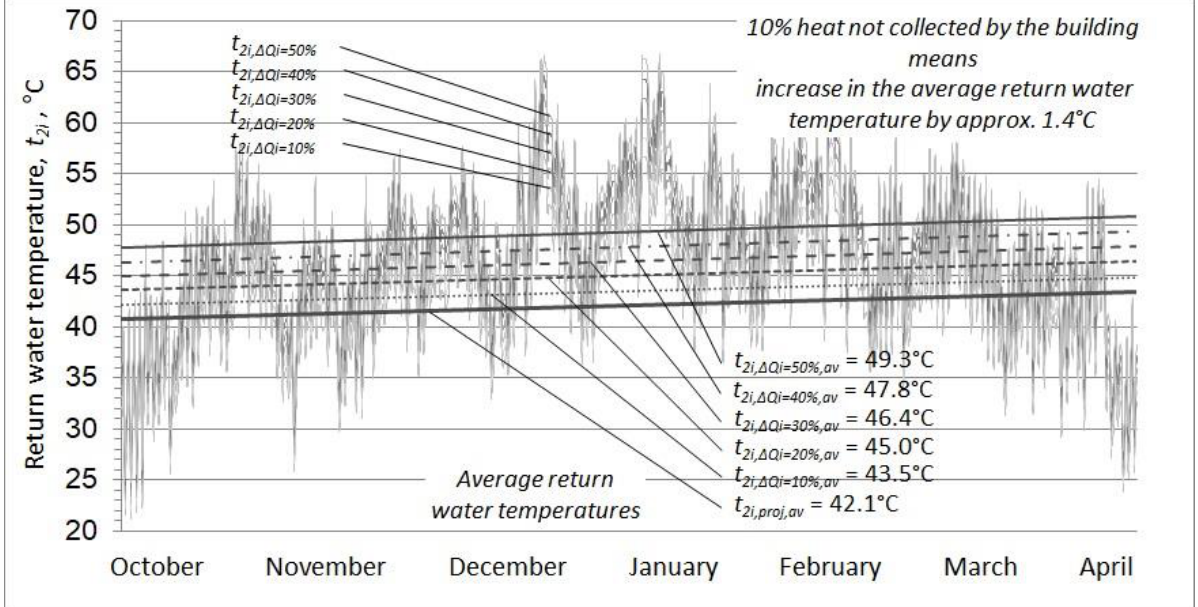
Figure 6 . Distribution and average values of return water temperatures in the installation under reference conditions and for relative characteristics .